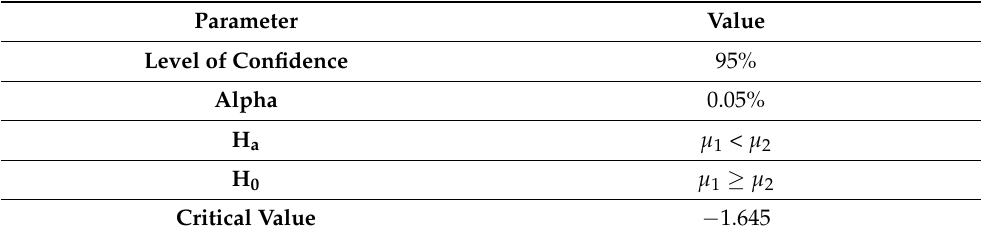
Table 7. Summary of parameters for the z-test.